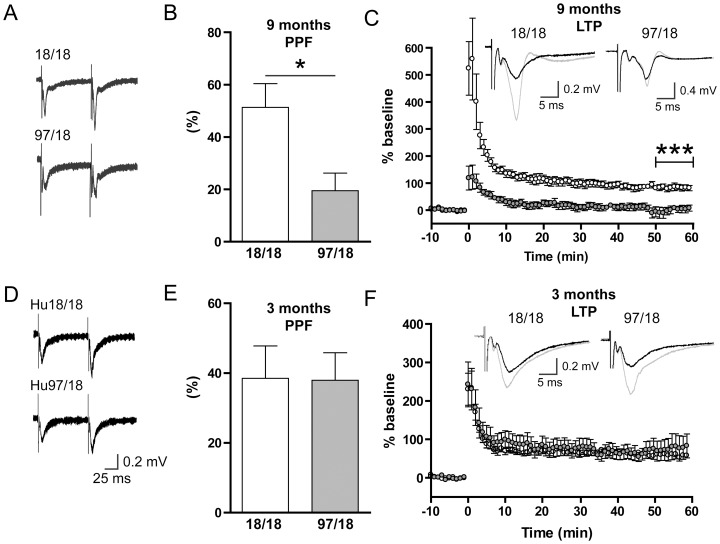
Long-term potentiation (LTP) is impaired in 9-month old Hu97/18 CA1.(A) Representative fEPSP traces from hippocampal slices of 9-month old Hu18/18 and Hu97/18 mice in response to two 0.1 ms pulses separated by 100 ms. fEPSPs were recorded in CA1 stratum radiatum during stimulation of the Schaffer collateral pathway. (B) Paired pulse facilitation (PPF) was measured by dividing the slope of the second response to that of the first and was expressed as percent increase. PPF was significantly lower in Hu97/18 CA1 (Hu18/18 n = 8, Hu97/18 n = 6). (C) fEPSPs were normalized to a 10-minute baseline period prior to high-frequency stimulation (HFS; 100 Hz for 1 s×3, 10 s inter-train interval). LTP was easily obtained in hippocampal slices from Hu18/18 mice (n = 6) but showed severe impairment in slices from Hu97/18 mice (n = 6). Representative traces before (black) and 50–60 minutes after (grey) HFS are shown. ***p<0.0001, t-test of average % above baseline 50–60 minutes post-HFS. (D–F) Paired pulse facilitation (D,E) and LTP (F) graphs as above but conducted in slices from 3-month old animals. n = 6 for each genotype for both (E) and (F).